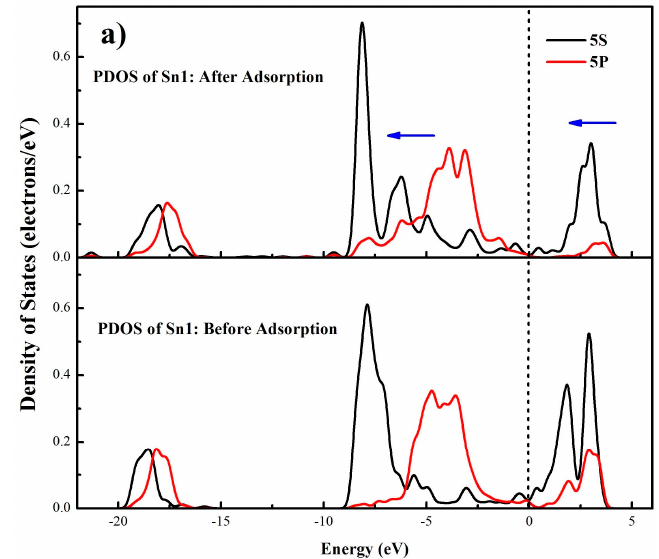
Figure 10. Cont. Figure 10.